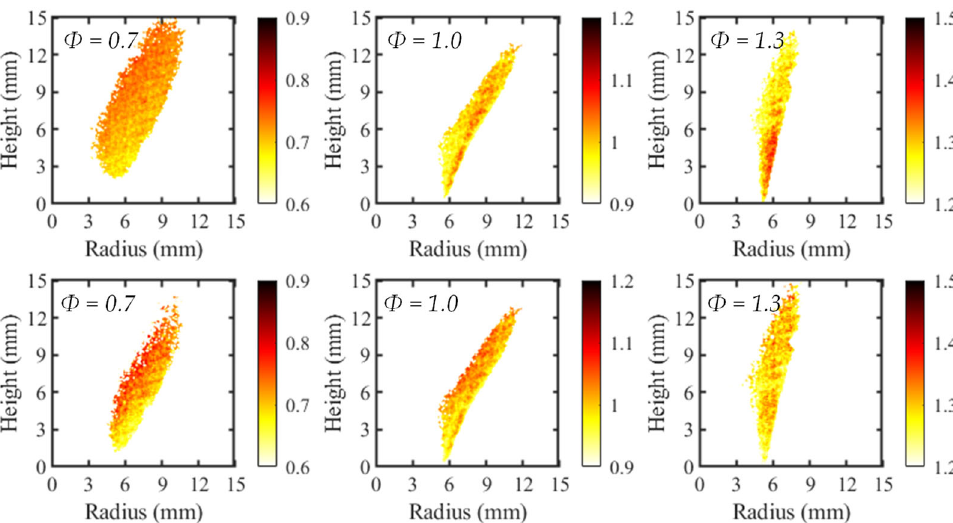
Figure 8. Equivalence ratio maps for two ‐ line ( top ) and four ‐ line ( bottom ) imaging methods.